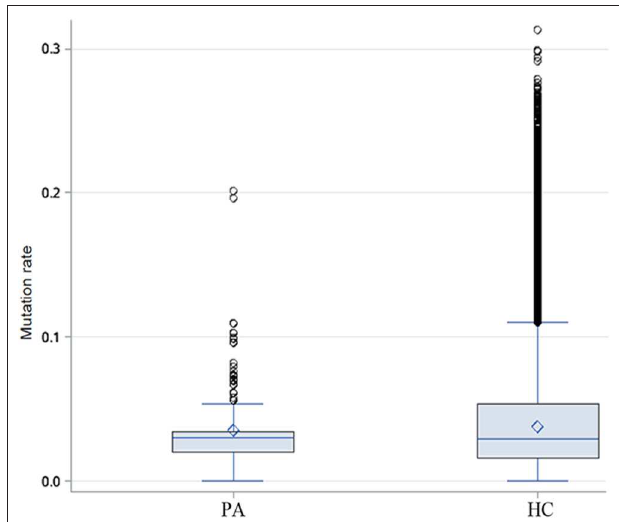
FIGURE 7 | Difference of heavy chain mutation rate between patients and healthy people. Box-and-whisker plots display the minimum value, the first quartile, the median, the third quartile, and the maximum value. PA: patients, HC: healthy